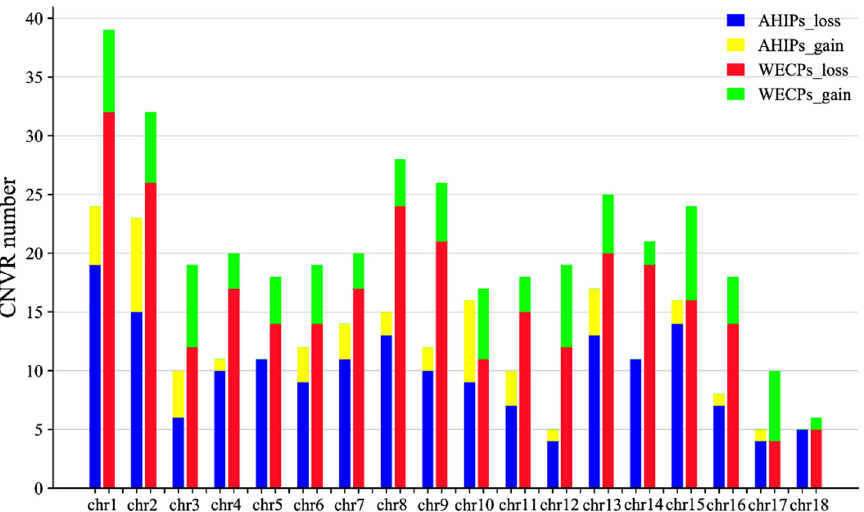
Figure 1. Statistical bar graphs of CNVRs in autosomes of the AHIP and WECP populations. A total of 604 CNVRs in the AHIP and WECP populations were on autosomes, colored in blue (AHIPs_loss), yellow (AHIPs_gain), red (WECPs_loss), and green (WECPs_gain), respectively. Y -axis values are the number of CNVRs and X -axis values are chromosomes.